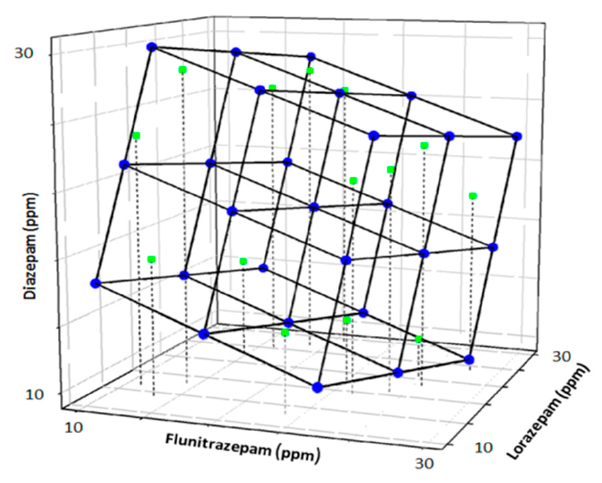
Figure 4. Scheme of the modified full factorial design used as train subset (blue) and randomly generated external test subset (green).